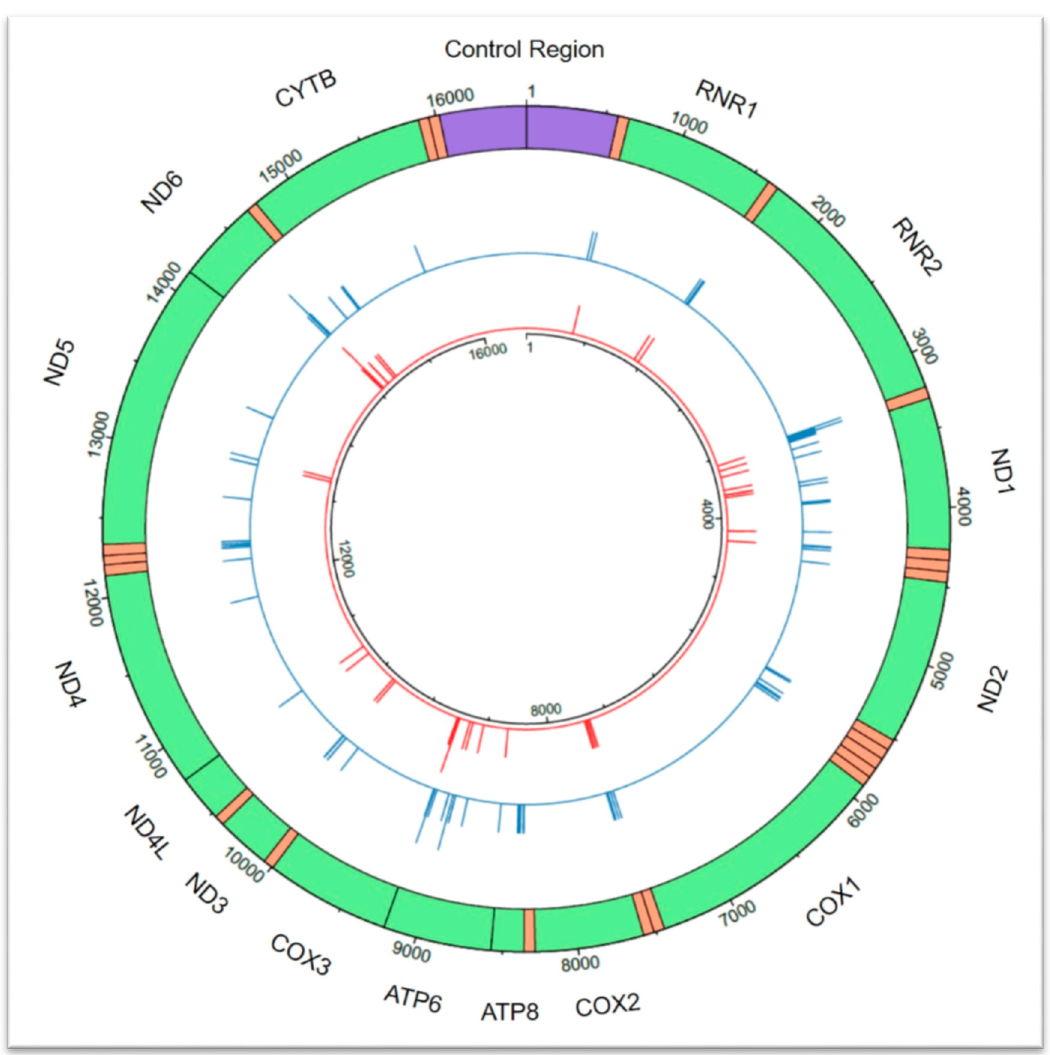
Figure 1. Circular depiction of the 92 confirmed pathogenic variants affecting 92 coding region (codR) positions across the mitochondrial genome as described in MitoMap [8]. Homoplasmic state ( n = 37) pathogenic variants are visible in the inner circle in red, and heteroplasmic state ( n = 83) pathogenic variants are presented in the outer circle in blue. Pathogenic variants are represented by a line at the corresponding nucleotide position. The height of the line corresponds to the number of pathogenic variants observed at each nucleotide position, up to a maximum of two for both homoplasmic and heteroplasmic states. The control region is shown in purple, transfer RNA (tRNA) regions are orange, and codR genes are green and labeled accordingly with the corresponding gene. RNR1 = 12S RNA; RNR2 = 16S RNA; ND1 = NADH dehydrogenase 1; ND2 = NADH dehydrogenase 2; COX1 = cytochrome c oxidase I; COX2 = cytochrome c oxidase 2; ATP8 =